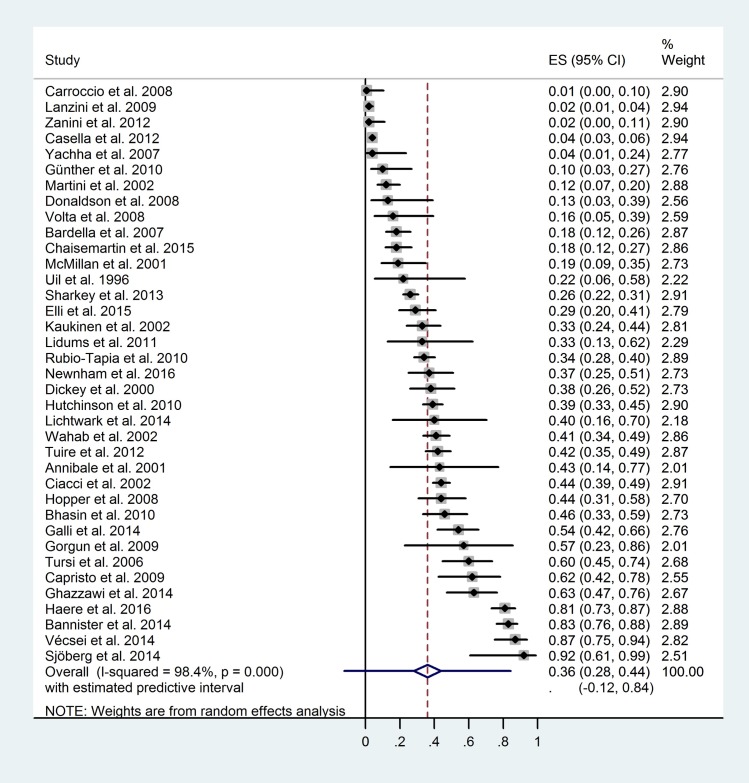
Forest plot: Complete mucosal recovery ratios of each study included.